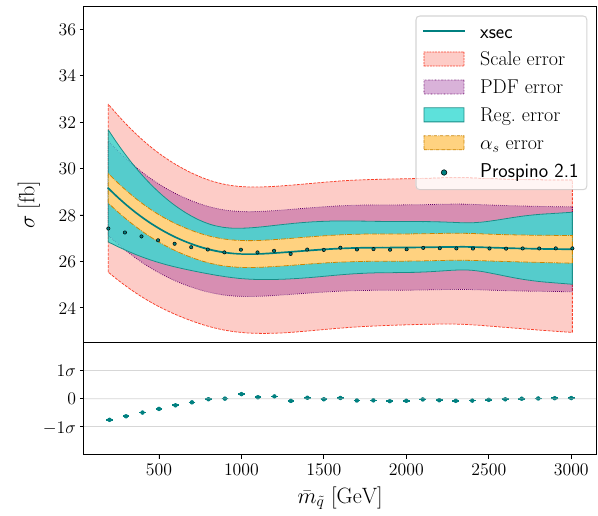
Fig. 19 Stop pair-production cross-sections as a function of the aver- age of the first and second-generation squark masses, for m ˜ t 800GeV. The xsec prediction and 1 σ regression error is in light green, the scale error in pink, the PDF error in violet, and the α s error in yel- low. The Prospino values are shown as dots, and below we show the residual between the xsec regression result and